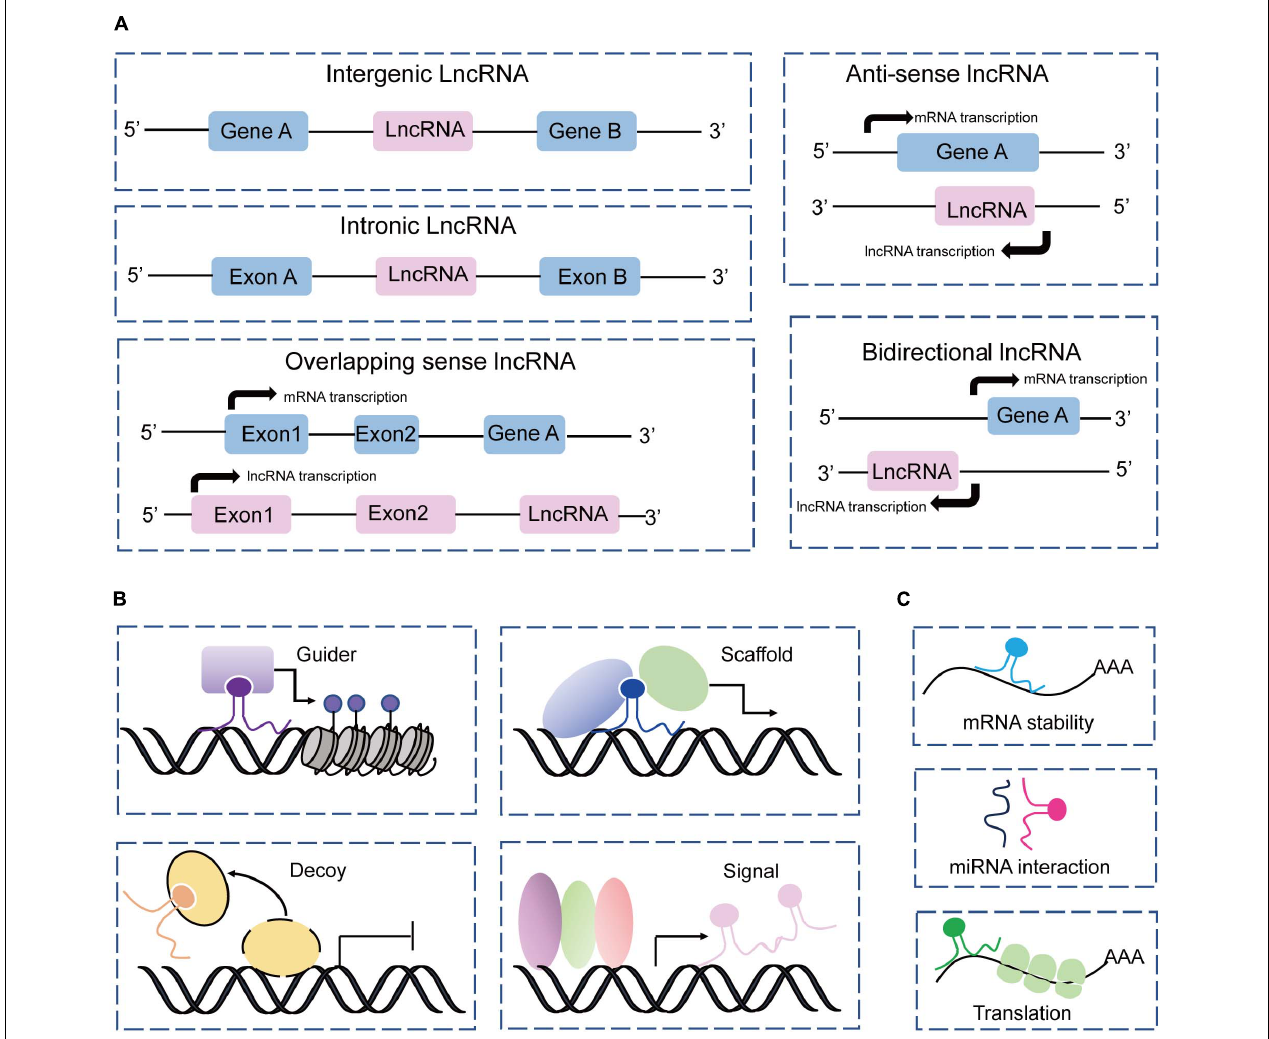
FIGURE 2 | Classification and mechanism of lncRNAs. (A) Classification of lncRNAs according to the protein-coding genes as intergenic, intronic, sense, antisense, and bidirectional. (B) LncRNAs acting as guides, scaffolds, decoys, and signals to perform their functions with DNAs and proteins. (C) LncRNAs interact with RNAs to regulate RNA stability, and translation, and sponge